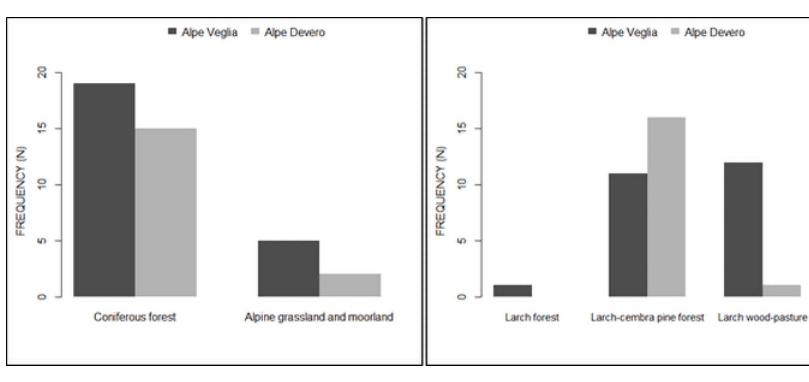
Figure 7 Frequency of host trees by vegetation type.